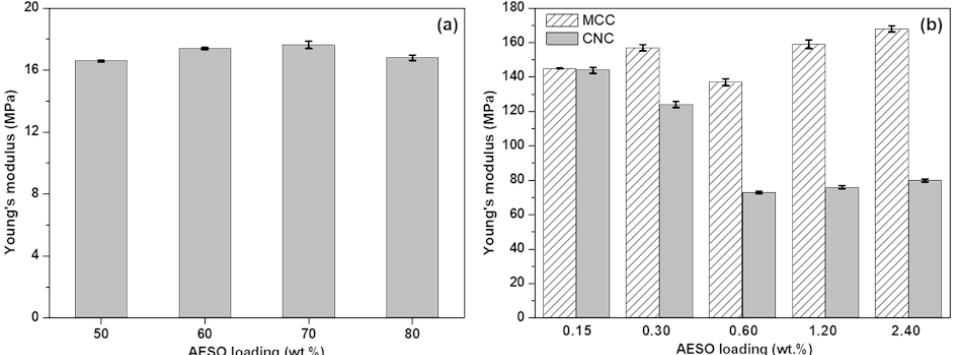
Figure 5. Young’s modulus values of PEGDA / AESO 3D-printed systems ( a ) and of P.A.20:80 con- taining different amounts of MCCs and CNCs ( b ).